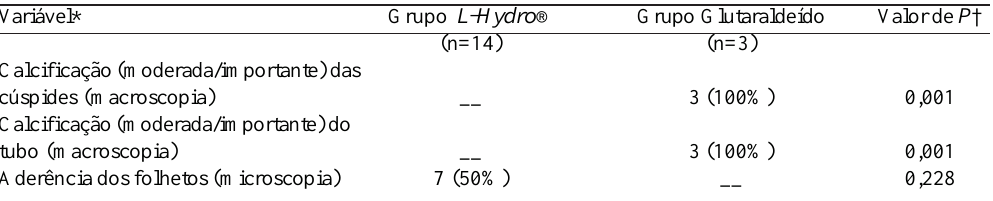
Tabela 4. Análise estatística da macroscopia (Grupos L-Hydro® e Glutaraldeído).